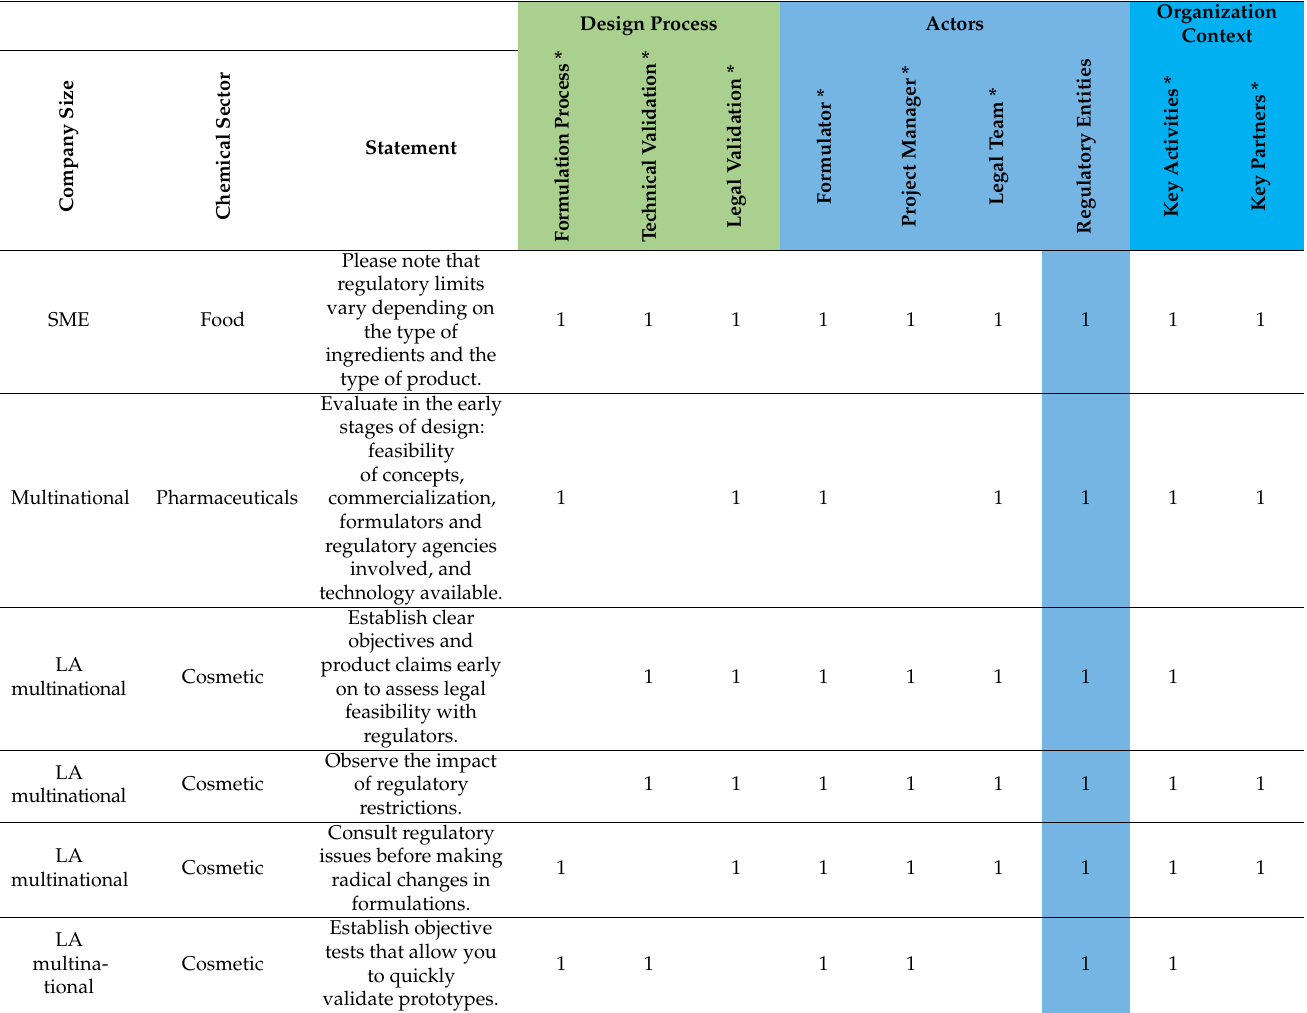
Table 5. The output of example 1: recommendations, and related information, when filtering the database for “regulatory